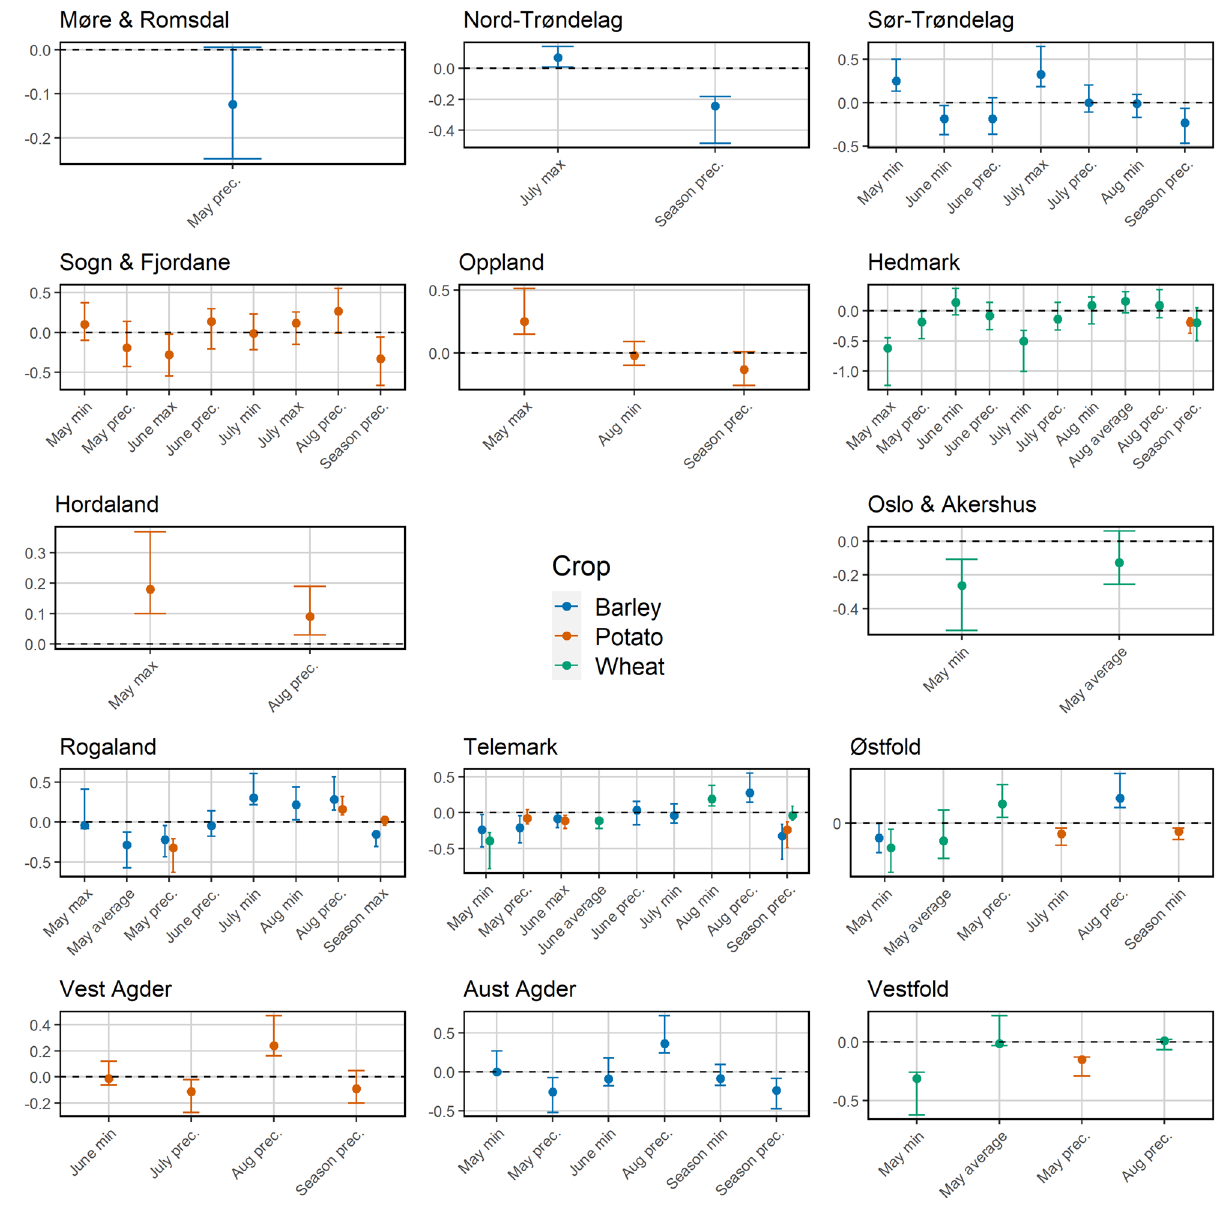
Figure 4. Standardised regression coefficients (all y-axes) from county-level crop models using LASSO, with bootstrapped 95% confidence intervals. The coefficients shown are those that were not reduced to zero and are therefore considered to be the most important predictors of detrended yield. There is no graph for Buskerud County because all predictors were reduced to 0 for all crops. (Abbreviations: min minimum temperature, max maximum temperature, prec precipitation). Coefficients and confidence intervals for these models can be found in Table